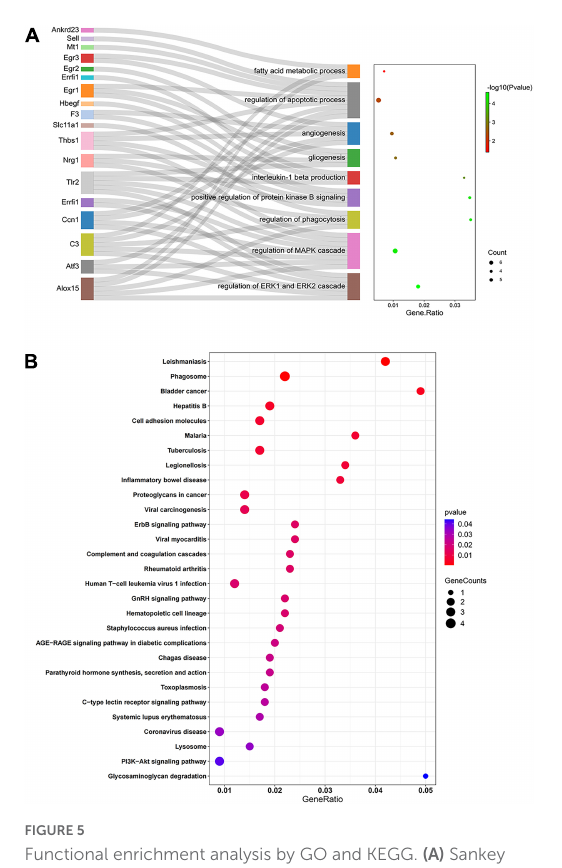
FIGURE4 Changes in gene expression profiles. (A) The overlap of DEGs in the comparison D vs. C and M vs. D presented as a Venn diagram. (B) Heatmap representing the relative expression levels of the overlapping DEGs in the comparisons D vs. C and M vs. D. In the heatmap, red and blue represent up regulation and down regulation respectively, and white represents no change.